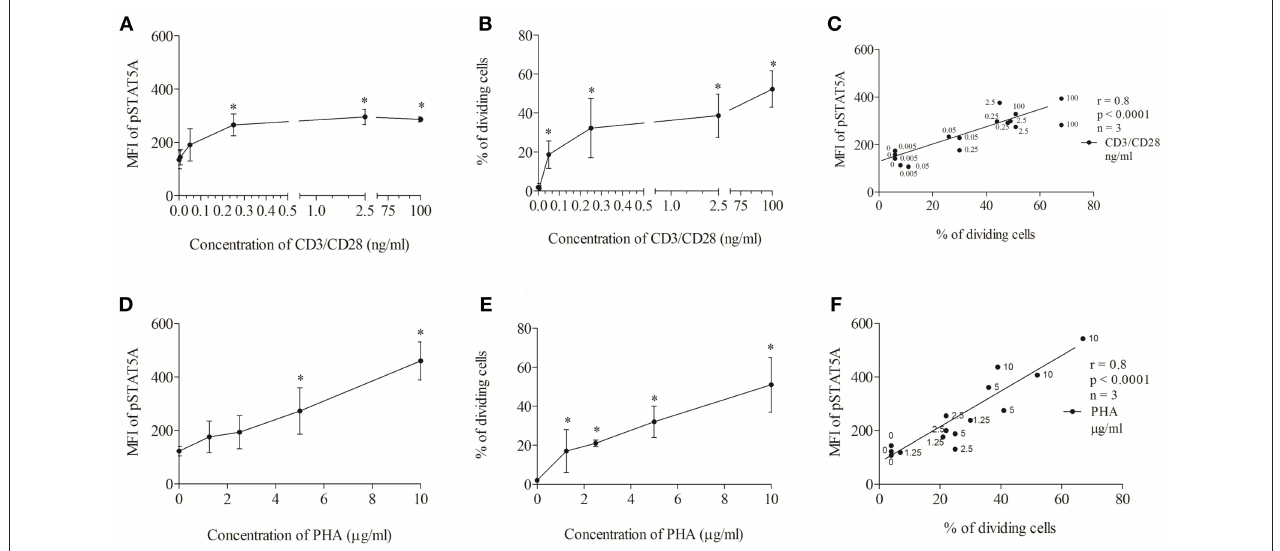
FIGURE 3 | Concentration dependent correlation between the percentage of dividing cells and STAT5A phosphorylation. PBMCs (1 * 10 6 cells/ml) were treated with CD3/CD28 (0, 0.005, 0.05, 0.25, 2.5, and 100ng/ml) or PHA (0, 1.25, 2.5, 5, and 10 µ g/ml). After 24 and 72h, pSTAT5 (A,D) and proliferation (B,E) were determined, respectively. Correlation between the percentage of dividing cells (72h) and STAT5A phosphorylation (24h) dependent on the concentration of the stimulus (C) CD3/CD28, (F) PHA.* p < 0.05; r, Spearman’s correlation coefficient; n = 3 independent experiments, MFI, median fluorescence intensity.